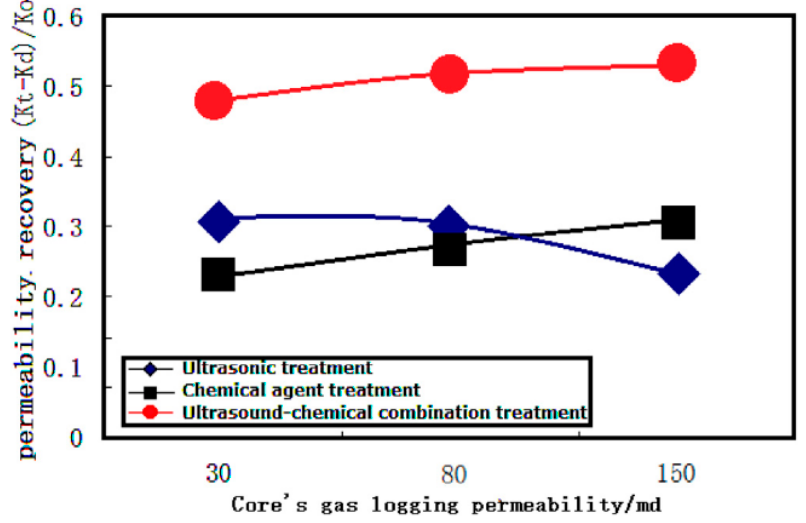
Figure 9. Differences between using an ultrasound, chemical, or a combination of ultrasound and chemical removal technology to treat asphaltene deposition in cores (reprinted from Xu and